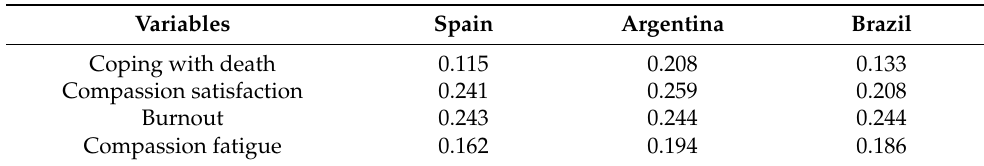
Table 4. Variance accounted for by the coping with death and professional quality of life dimensions across countries based on the R 2 values.